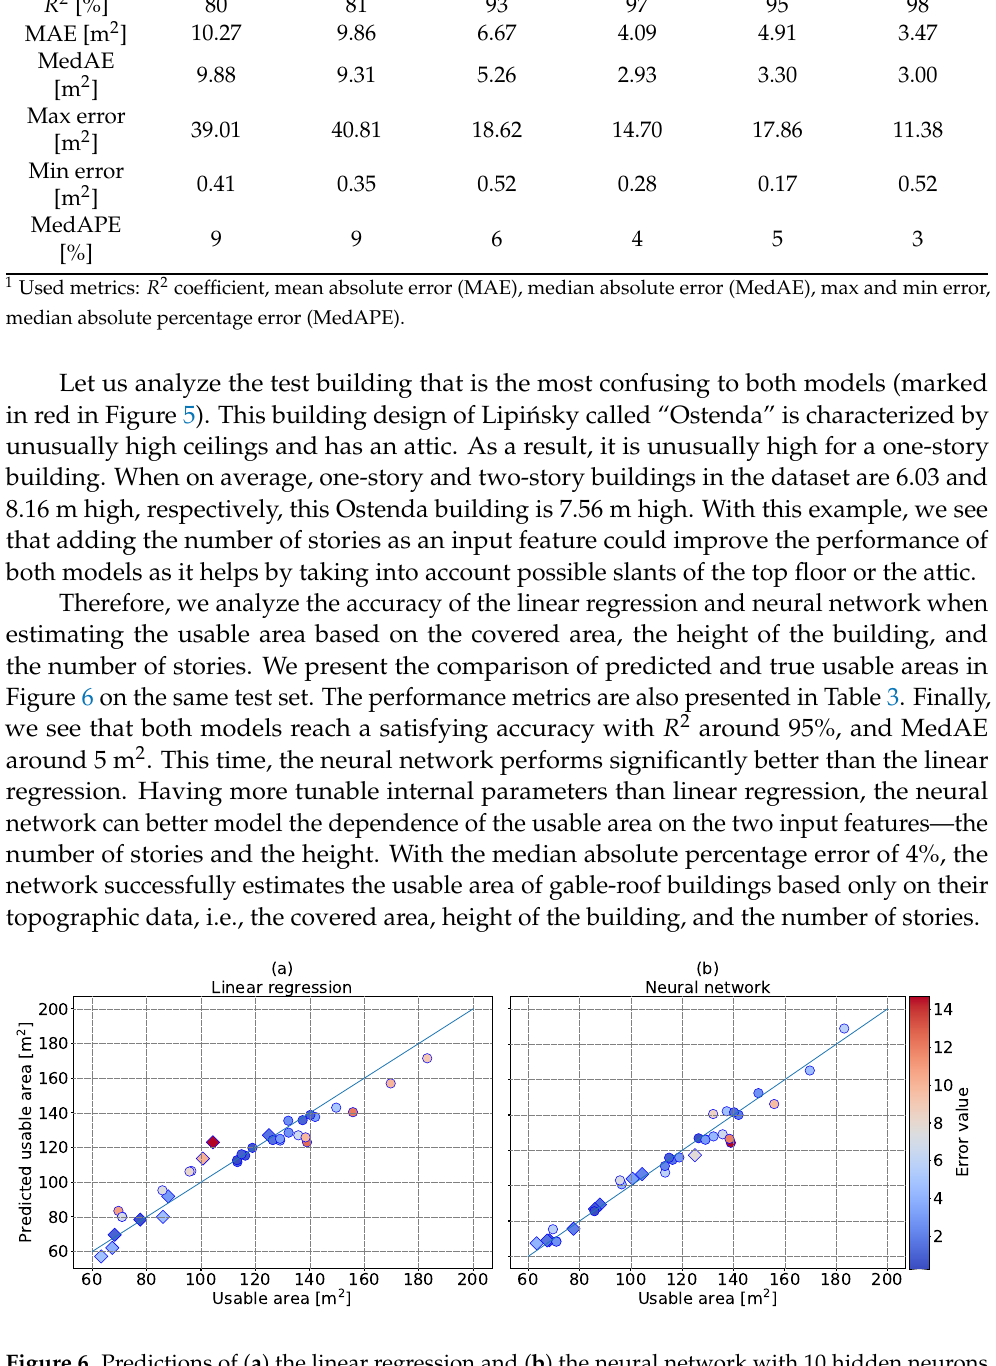
Figure 6. Predictions of ( a ) the linear regression and ( b ) the neural network with 10 hidden neurons of the usable area of buildings from architectural bureaus, with a distinction between one- (diamonds) and two-story (dots) buildings. Input features are the covered area, the building’s height, and the number of